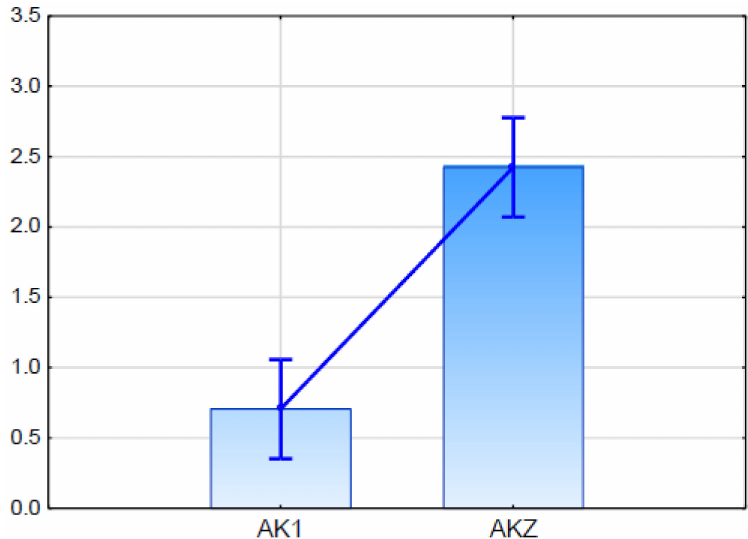
Figure 5. Relative expression (fold change in relation to the ACT and GAPDH) of putative ScABCG11 established in qPCR (quantitative PCR) for glaucous (AK1) and nonglaucous (AKZ) rye inbred line. Vertical bars indicate +/ − standard error. Di ff erences are statistically significant in Kruskal-Wallis